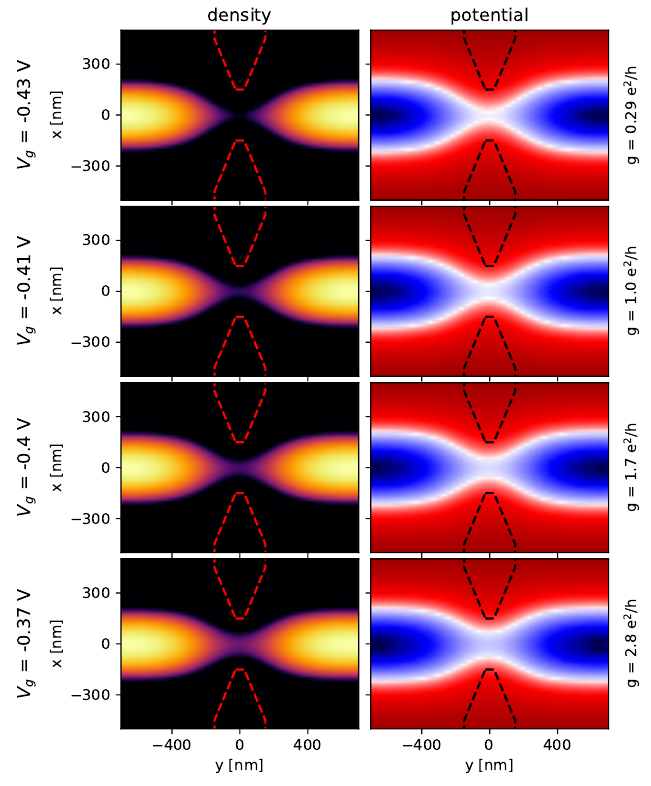
Figure 13: 2D maps of the density (left) and electric potential (right) for four differ- = − 0.43, − 0.41, − 0.4 and − 0.37V (top to bottom) for a QPC. ent gate voltages V g Left: density of the 2DEG (black corresponds to zero density). Right: electric poten- tial (blue corresponds to negative potential where the 2DEG lies, white is zero and red corresponds to positive potential where the 2DEG is depleted). An additional side = − 0.8 depletes the gas far away from the QPC. The dashed lines indicate gate V s the gates of the QPC. The scale of variation of the potential is shown in Fig.